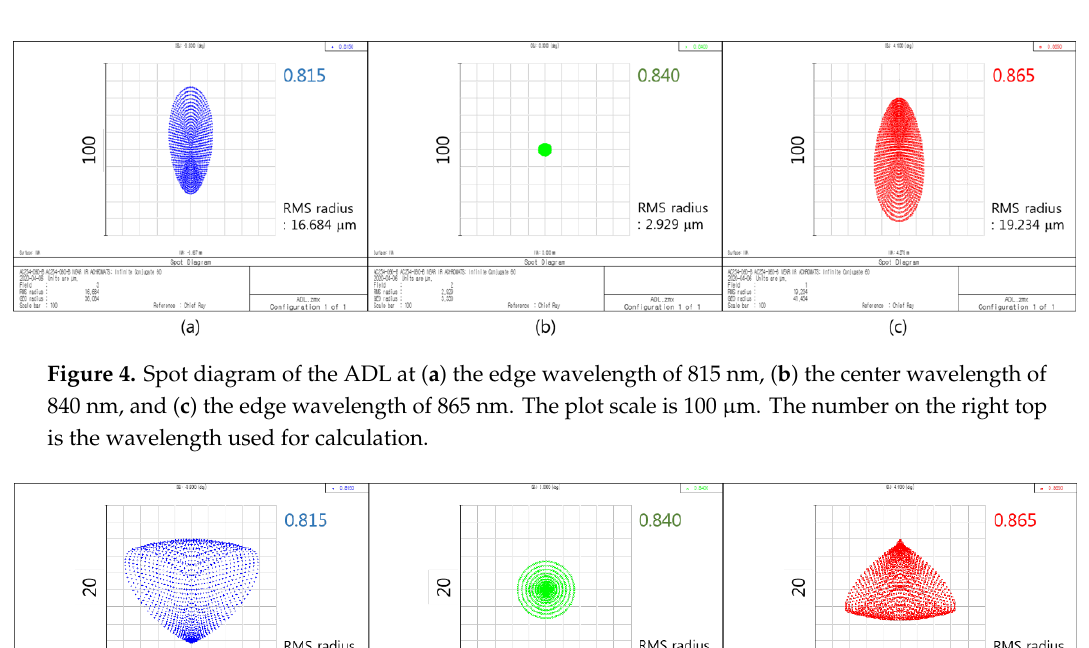
Figure 4. Spot diagram of the ADL at ( a ) the edge wavelength of 815 nm, ( b ) the center wavelength of 840 nm, and ( c ) the edge wavelength of 865 nm. The plot scale is 100 m. The number on the right top is the wavelength used for calculation. Figure 5. Spot diagram of the TFL at ( a ) the edge wavelength of 815 nm, ( b ) the center wavelength of 840 nm, and ( c ) the edge wavelength of 865 nm. The plot scale is 20 µ m. The number on the right top is the wavelength used for calculation.